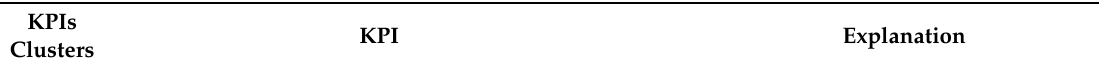
Table 2. Learning Analytics KPIs—indicators explanations and data